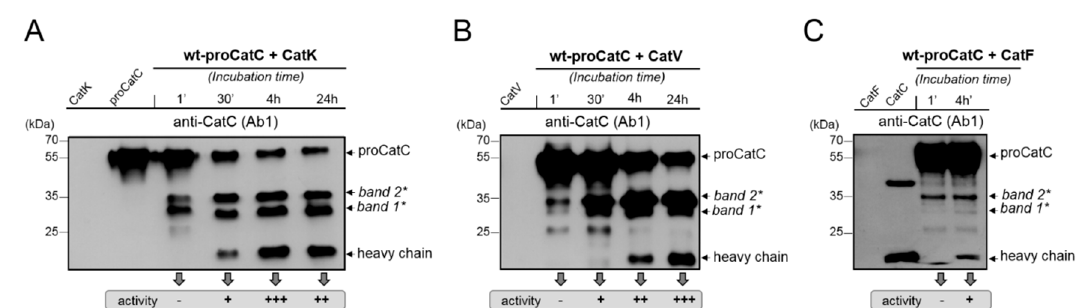
Figure 2. Wt-proCatC maturation by CatK, CatV, and CatF. Western blot analysis of endoproteolytic cleavage of proCatC by recombinant cathepsins using an anti-CatC Ab. Wt-proCatC (2 µM) was incubated at 37 °C for different time intervals with ( A ) human CatK (0.1 µM) , ( B ) human CatV (0.1 µ M), and ( C ) human CatF (0.5 µ M). The progress of the cleavage reaction was monitored by western blot